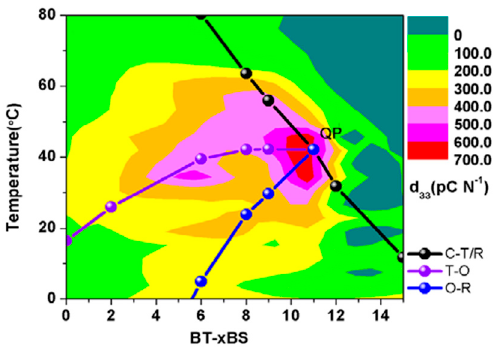
Figure 16. Contour map of the d 33 coefficient in temperature-composition dimensions of BT–BS piezoelectric materials [89].